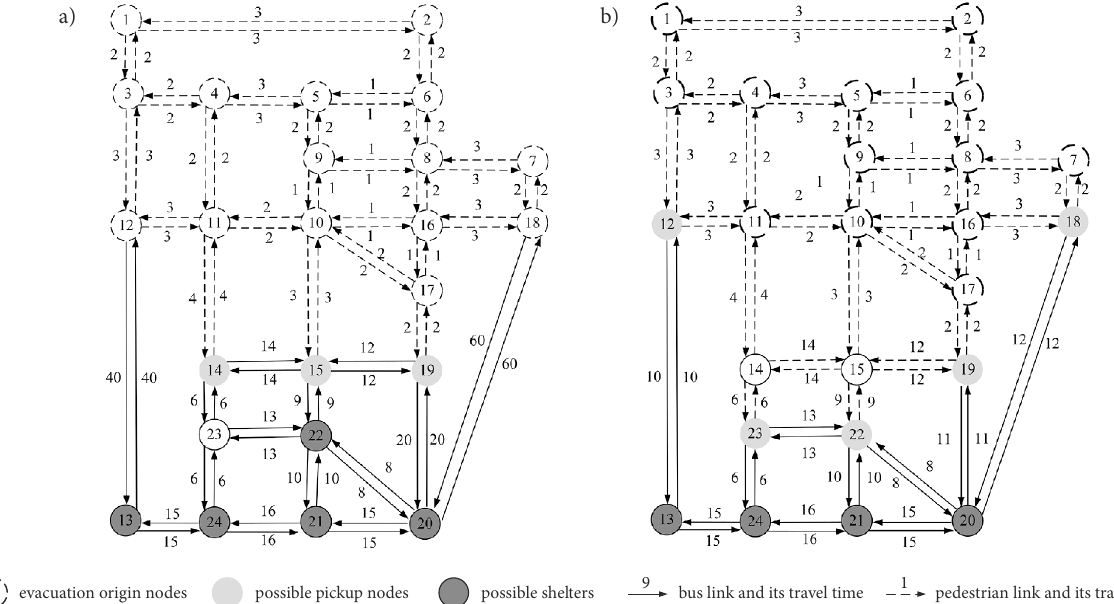
evacuation origin Figure 2. Network used in numerical experiments: a – under Scenario 1; b – under Scenario 2